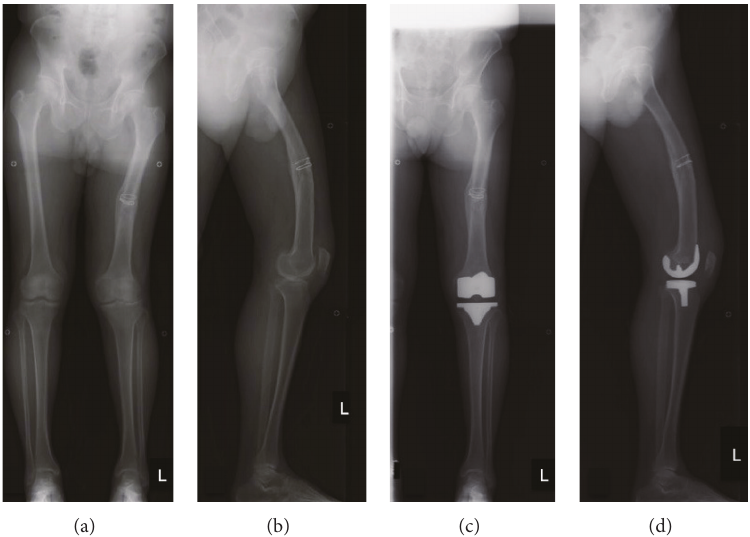
Figure 1: Case 1: preoperative anteroposterior standing radiograph (a) showed an extra-articular valgus deformity (11 ∘ ) in the femoral shaft. Lateral view (b) revealed 23 ∘ antecurvatum deformity in the sagittal plane. Postoperative anteroposterior standing radiograph (c) demonstrated restored mechanical axis. In lateral view (d), femoral component was placed according to the intraoperative navigation